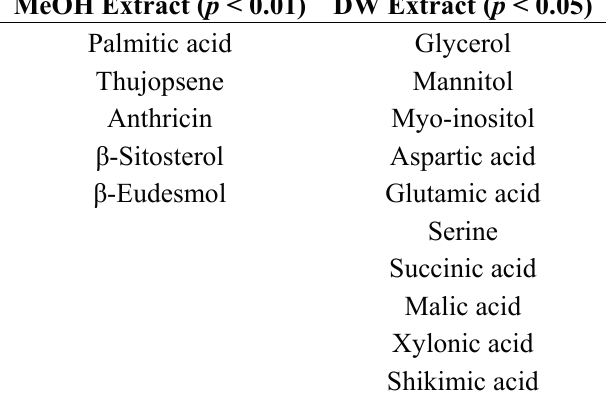
Figure 4. S-plots obtained by orthogonal partial least-squares discriminant analysis (OPLS-DA) of methanol and water extracts of Chamaecyparis obtusa leaves. Table 2. Metabolites identified in methanol (MeOH) and distilled water (DW) extracts of Chamaecyparis obtusa leaves separated by orthogonal partial least-squares discriminant analysis